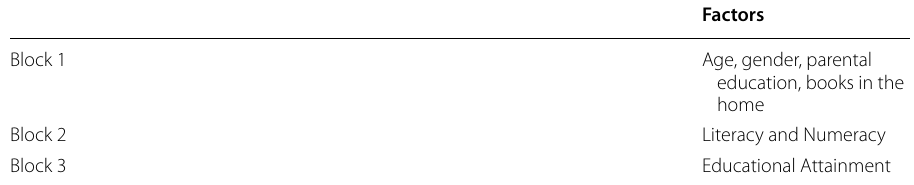
Table 3 Order of introduction of factors into logistic regression